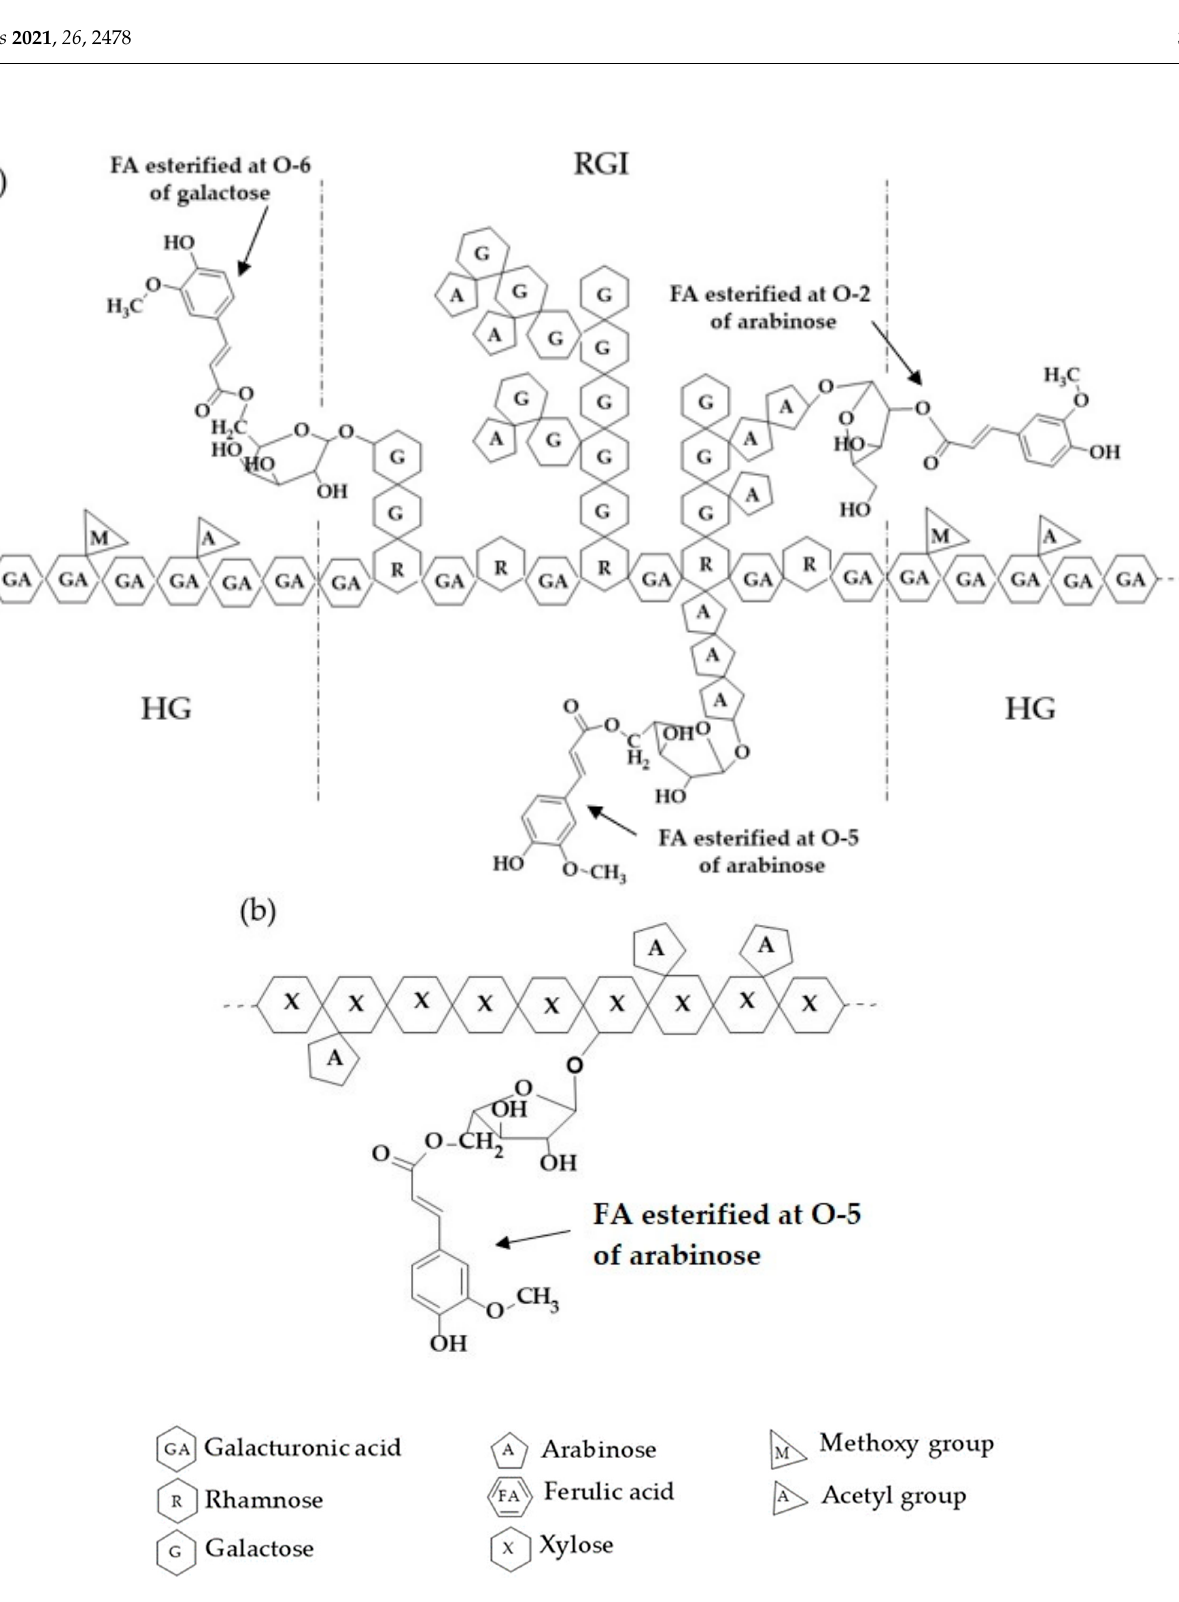
Figure 1. Schematic chemical structure for ferulated pectins ( a ) and ferulated arabinoxylans ( b ). HG = Homogalacturonan region, RGI = Rhamnogalacturonan I region.